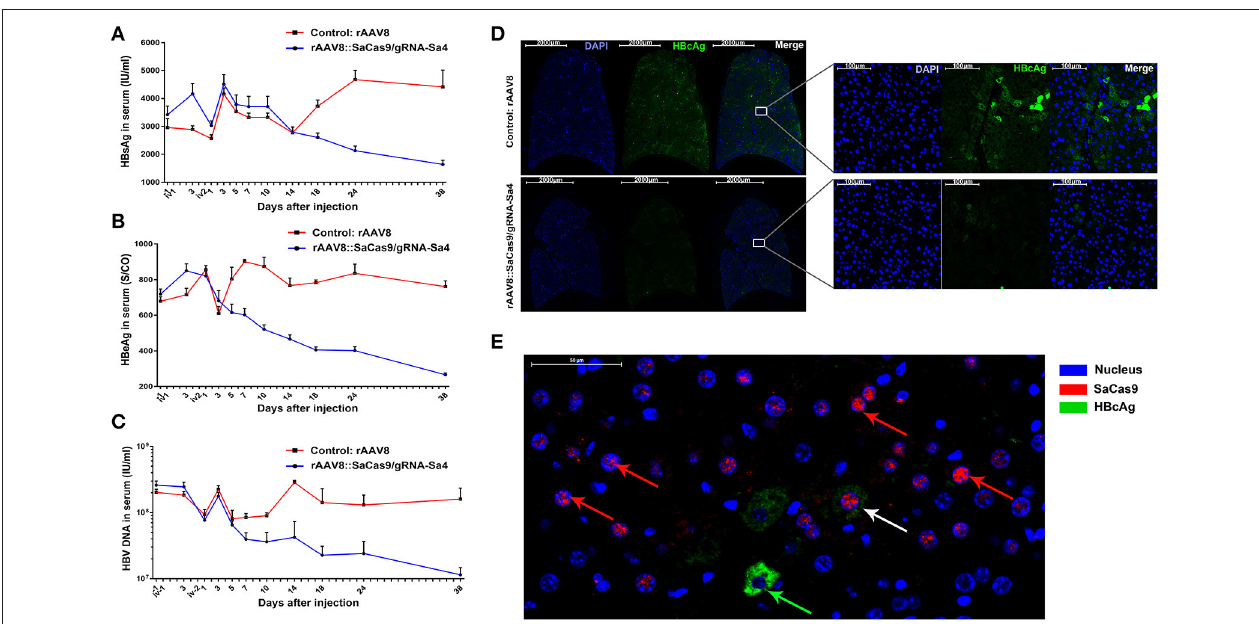
FIGURE 2 | Inhibition of both HBV antigen expression and HBV replication by rAAV8::CRISPR-SaCas9 in HBV transgenic (HBV-Tg) mice. (A) Comparison of serum HBsAg levels measured in rAAV8-empty- and rAAV8::Sa4-treated groups at the indicated times after injection. (B,C) Comparison of serum HBeAg and HBV DNA measured in the aforementioned two groups at the indicated times after injection. (D) The results of immunocytochemistry/immunofluorescence (ICC/IF) analyses, performed with FITC-conjugated anti-HBcAg antibody. (E) Immunofluorescence labeling with anti-HA and anti-HBcAg antibodies showing the levels of SaCas9-HA (Cy3; red) and HBcAg (FITC; green) in the liver of HBV-Tg mice at Day 38 after injection; nuclei are stained blue with DAPI. In most of the liver cells of HBV-Tg mice transfected with rAAV8::CRISPR-SaCas9, HBcAg was not detectable (red arrows) or was less detectable (white arrow). While, an HbcAg-expressing liver cell (green arrows) has been found that didn’t transfected with